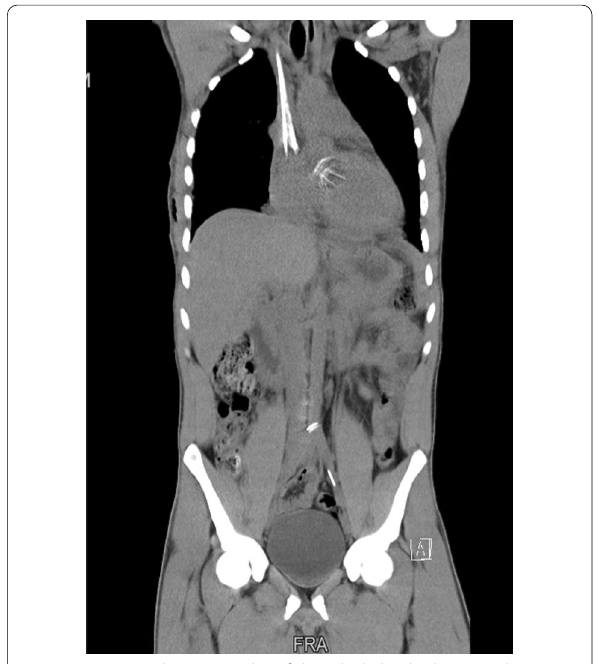
Fig. 4 Computed tomography of the whole body showing the mechanical mitral valve leaflet at the abdominal aortic bifurcation and left external iliac artery